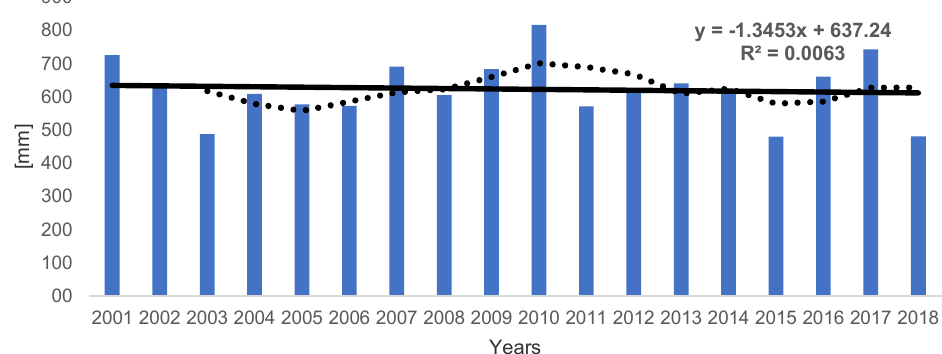
Figure 7. Annual precipitation totals averaged across Poland in 2001–2018. Table 1. Selected characteristics of monthly precipitation totals averaged across Poland in 2001–2018.